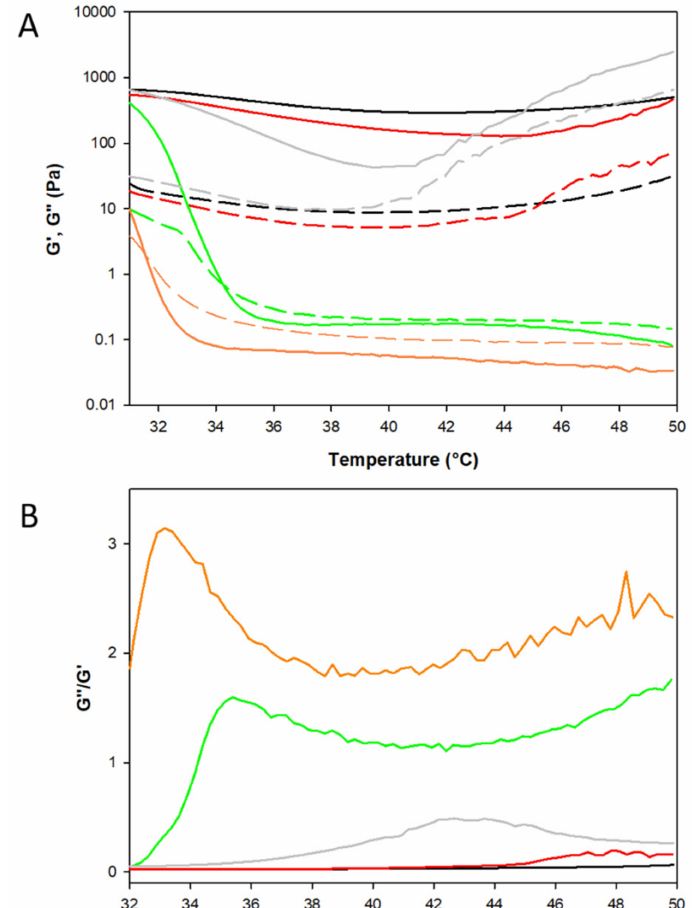
Figure 3. ( A ) Storage and loss moduli (G (cid:48) , full lines, G (cid:48)(cid:48) , dashed lines) of G 10 N 10 (green), G 10 C 20 N 10 (black), G 10 D 20 N 10 (red), G 10 C 80 N 1 0 (gray), and G 10 D 80 N 10 (orange). ( B ) Loss factor (G (cid:48)(cid:48) /G (cid:48) ) of G 10 N 10 (green), G 10 C 20 N 10 (black), G 10 D 20 N 10 (red), G 10 C 80 N 10 (gray), and G 10 D 80 N 10 (orange). The temperature sweep experiments were performed at 1 Hz and with 1% strain from an initial temperature of 25 ◦ C to a final temperature of 50 ◦ C at a heating rate of 1.0 ◦ C · min − 1 .